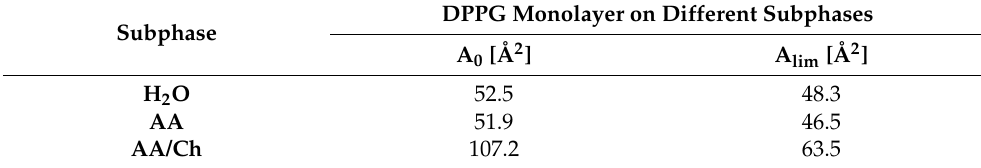
Table 1. Lift-off area (A 0 ) and limit area (A lim ) determined from the π -A isotherms for the DPPG monolayer on individual